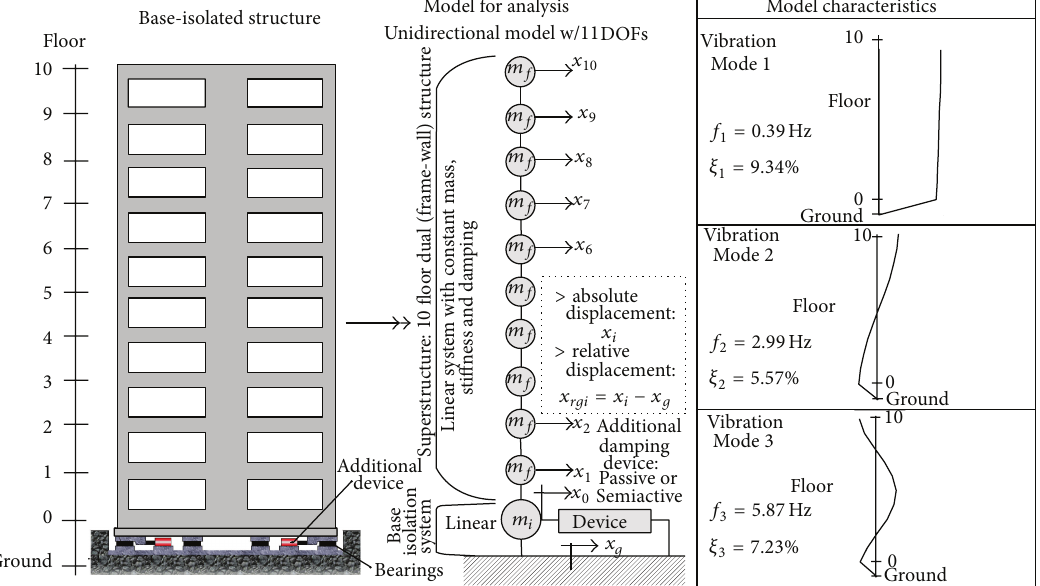
Figure 10: 10-storey base-isolated building and equivalent model for